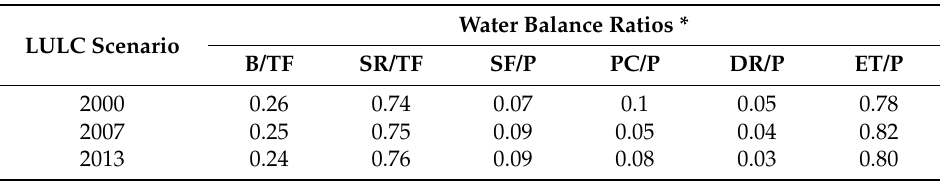
Table 8. Potential ratios of basin hydrology simulated on three LULC scenarios based on the hydrological year